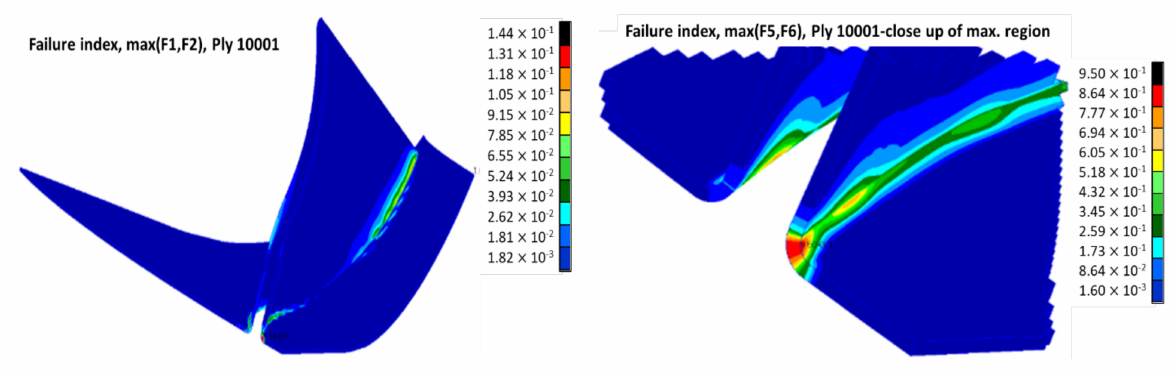
Figure 11. Maximum Hashin-Fabric failure index distribution values for layer